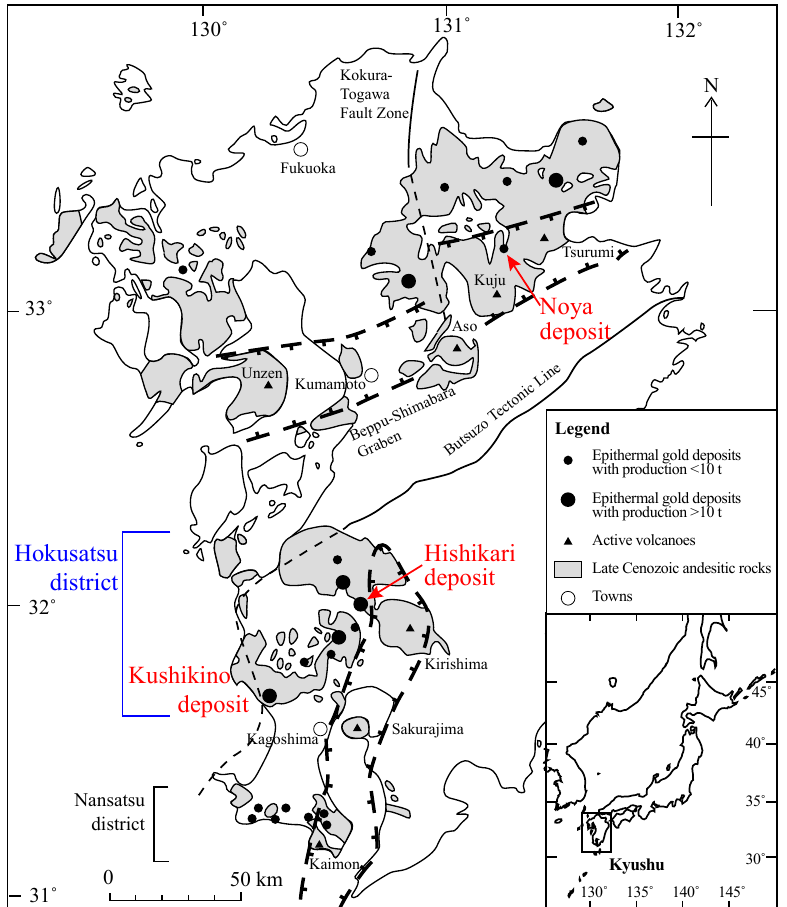
Figure 1. Epithermal gold deposits in Kyushu, southwestern Japan (produced from [12,17]). In southern Kyushu, epithermal gold deposits occur in Late Cenozoic subaerial andesitic to dacitic volcanic rocks in the Hokusatsu district. The basement rocks in the district are sedimentary rocks of the Lower Shimanto Group (Cretaceous accretionary wedge), which do not outcrop near the deposits. The location of the Hishikari, Kushikino, and Noya deposits are shown.